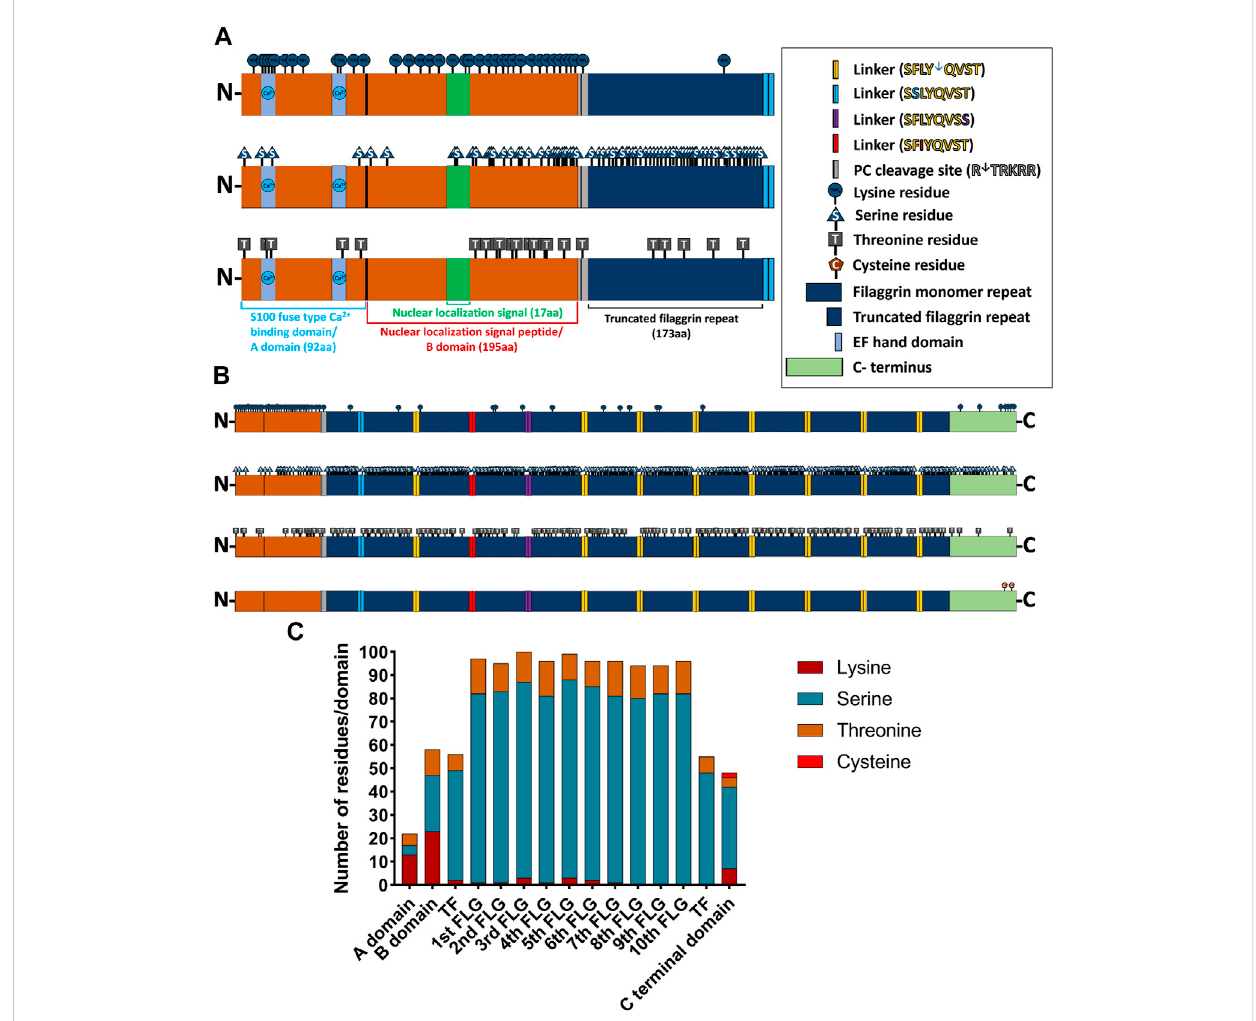
FIGURE 3 Distribution of ubiquitin (Ub)-conjugating residues in the pro fi laggrin wildtype sequence. (A) Illustration of N terminus of FLG. The N terminal of pro fi laggrin consists of a S100 fused type Ca ++ Binding domain (92 aa) also known as A domain followed by nuclear localization signal peptide (195 aa) also knownasBdomainandatruncated fi laggrin repeat(173 aa). Truncated fi laggrin repeatis fl ankedwith aPC cleavage sitewhich linksitwithBdomain and SASPase cleavage site which links it with rest of the fi laggrin. Like all the other S100 domain fi laggrin S100 domain consists of the Ca ++